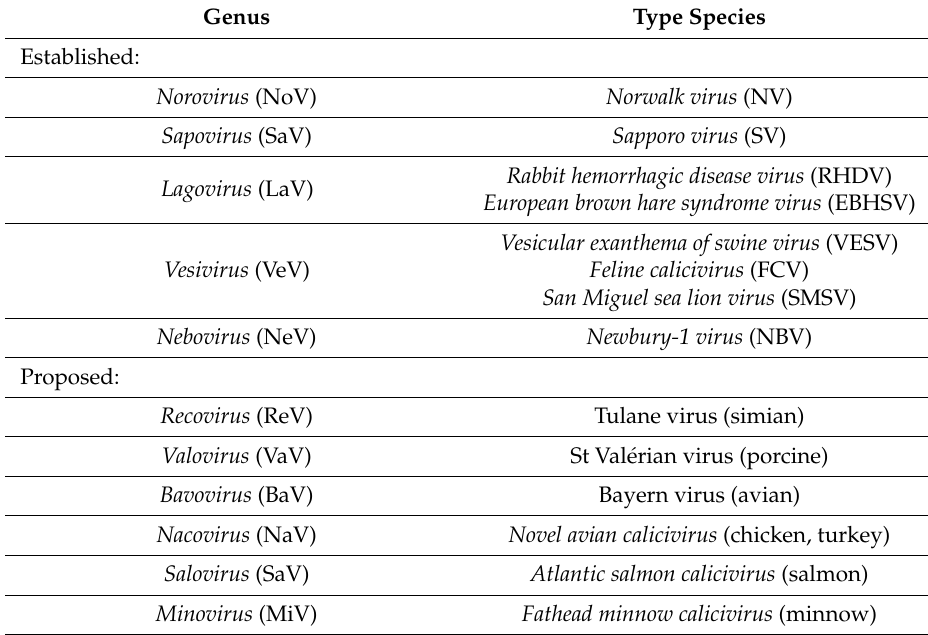
Table 1. Calicivirus classification including genera and type species (and abbreviations